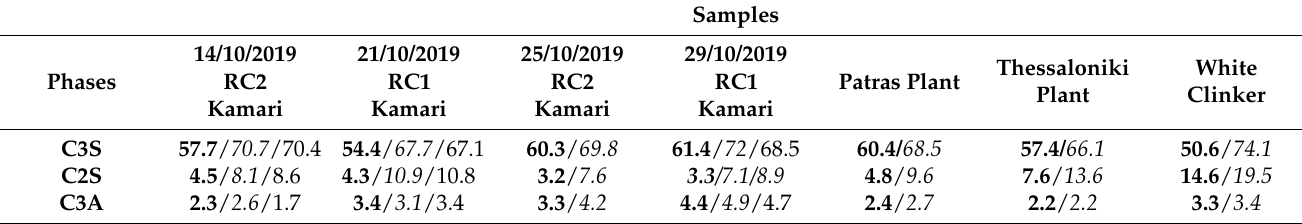
Table 1. Mineralogical composition of the cement clinkers (wt.%) determined by Rietveld refinement. The bold characters correspond to analyses with ZnO IS, the italics to analyses without IS and the plain characters to analyses provided by Titan cement Co. C3S = monoclinic tricalcium silicate, C2S = dicalcium silicate (sum of α , β and γ polymorphs), C3A = cubic tricalcium aluminate, C4AF = tetracalcium aluminate ferrite (brownmillerite), CH = calcium hydrate, M = periclase, C = lime, Am. Matter = amorphous matter, RC = rotary clinker. n.d. = not